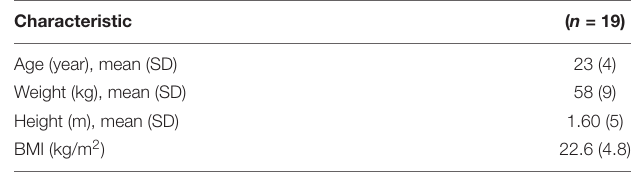
TABLE 1 | Characteristics of the